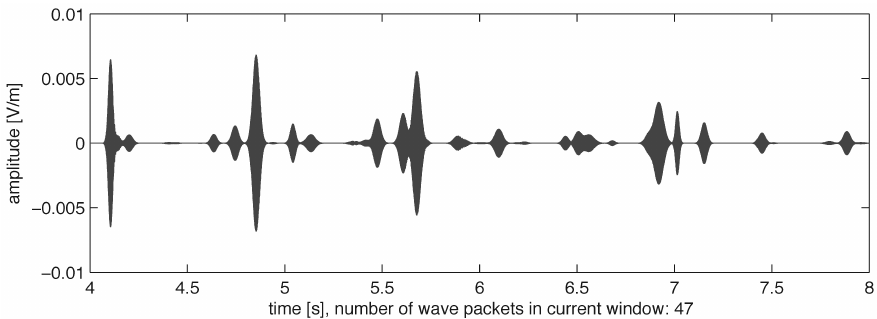
): N ( (cid:22) = (cid:0) 7 ; (cid:27) 2 = i